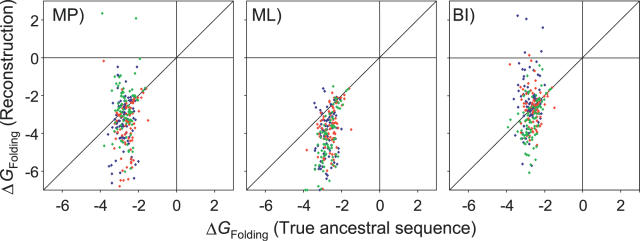
Stability (Represented as ΔG
Folding) for the True Ancestor and Reconstructed SequencesStability values shown for three nodes, as labelled in Figure S3: (A) shallow node, blue, (B) intermediate node, red, and (C) deep node, green. Each point represents the reconstruction of a single ancestral node in one of the 84 analysed simulations. Reconstructions were performed with MP, ML, and BI approaches. ΔG
Folding values represent the average of 100 reconstructions. Points on the diagonal represent reconstructions generating accurate ancestral protein stabilities.